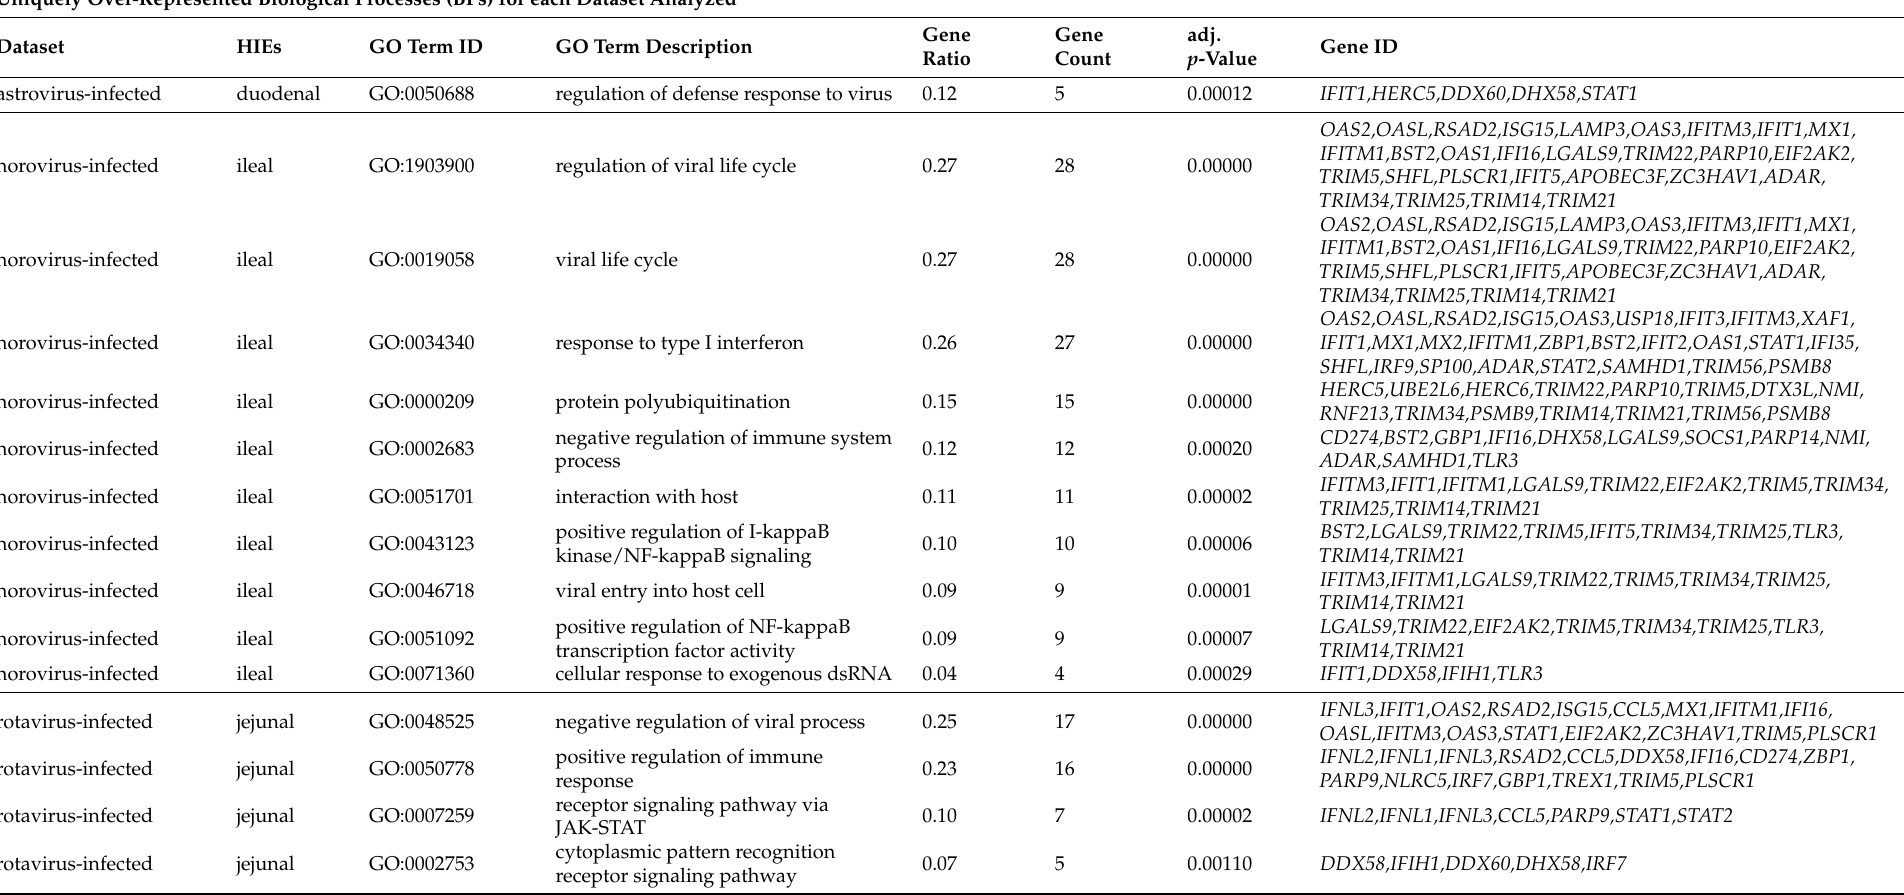
Table 4. Over-representation analysis of biological processes (BP) with the package ClusterProfiler in R was used to identify uniquely over-represented BPs for each dataset. A false discovery rate (FDR) adjusted p -value cutoff of <0.001 using the Benjamini–Hochberg (BH) step-up procedure was used to determine significant over-represented BP categories. BP categories unique to each dataset are indicated including the gene ontology (GO) term ID and description as well as the genes assigned to the GO term ID. Uniquely Over-Represented Biological Processes (BPs) for each Dataset